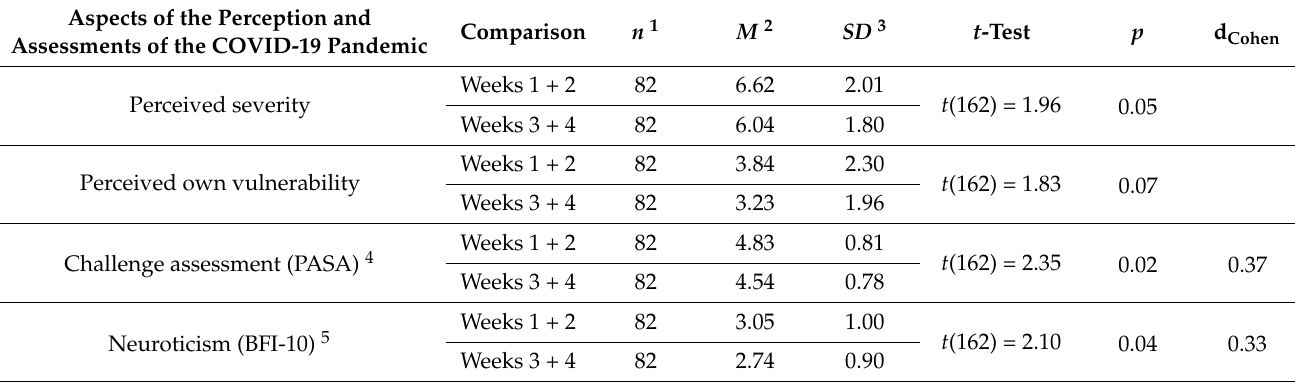
Table 3. Differences between the first and second half of the four-week investigation period regarding selected aspects of the perception and assessments of the COVID-19 pandemic.